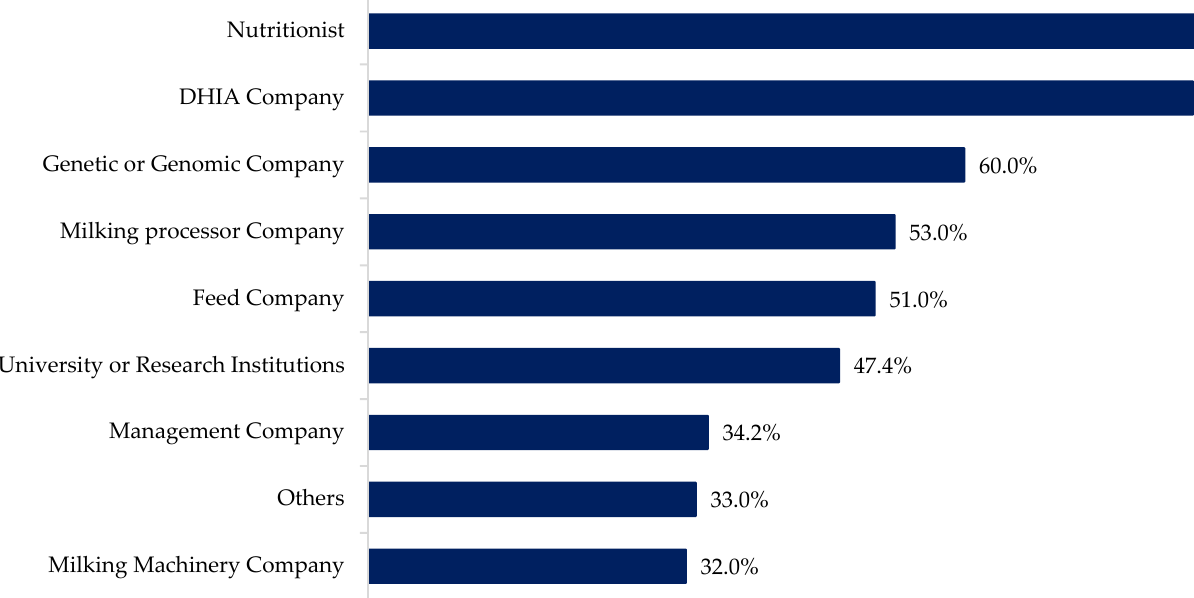
Figure 1. Percentage of respondents that read the terms and conditions of software or technology licenses before clicking “I agree”.